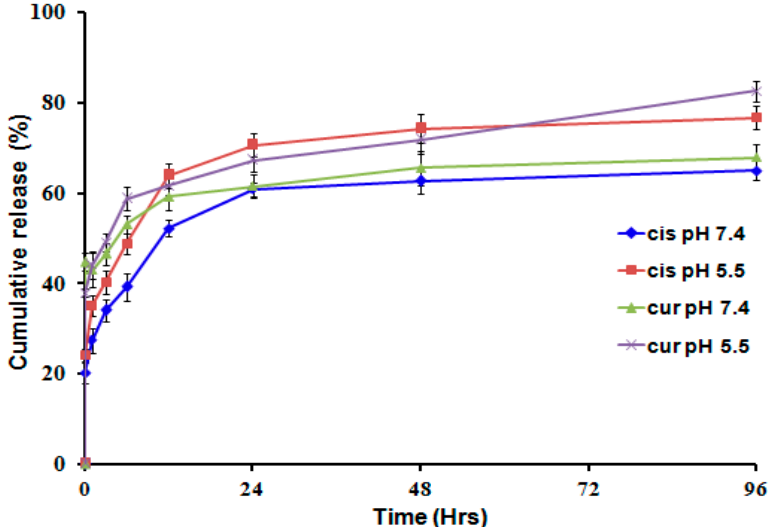
Figure 4. Release profiles of bioactive components from the dual drugs delivery system at pH = 7.4 and pH = 5.5.